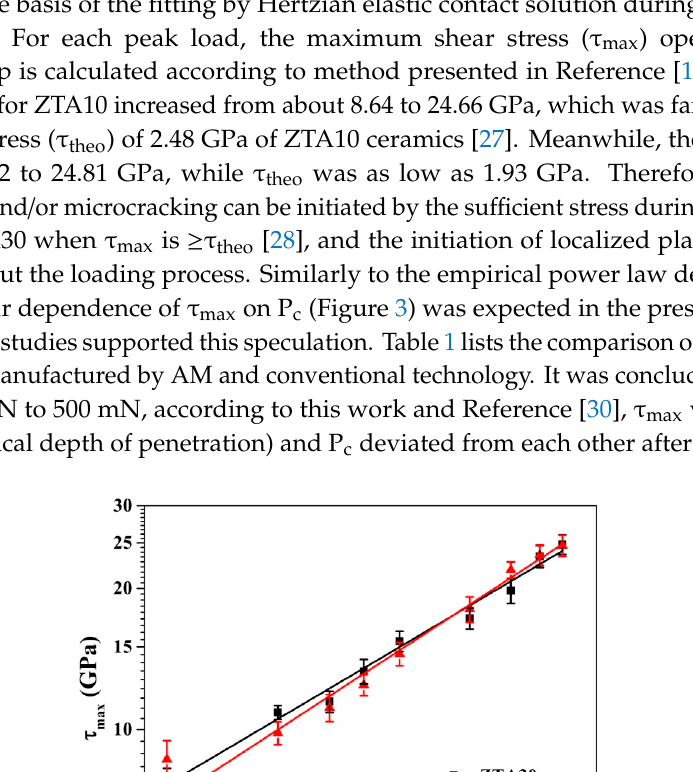
Figure 3. Maximum shear stress ( τ max ) variation underneath the nanoindentation tip with applied peak load.